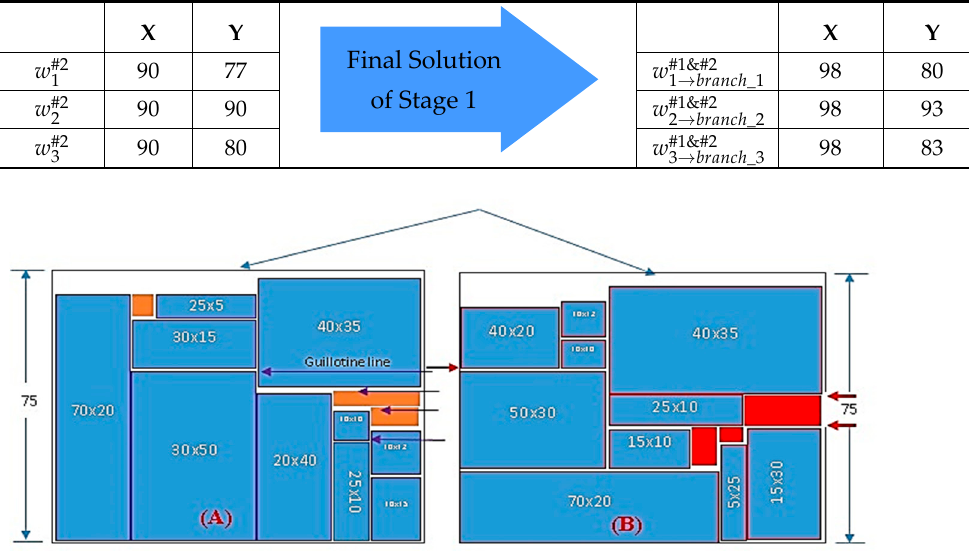
Table 14. The branches solutions obtained from stage-I.